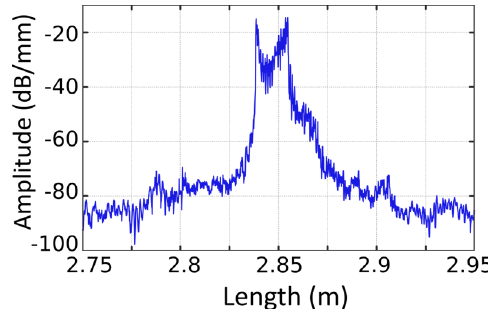
Fig. 1. Backscattered optical power as a function of fiber length for the MMF-RFG, located about 1.88 m from the connector of the